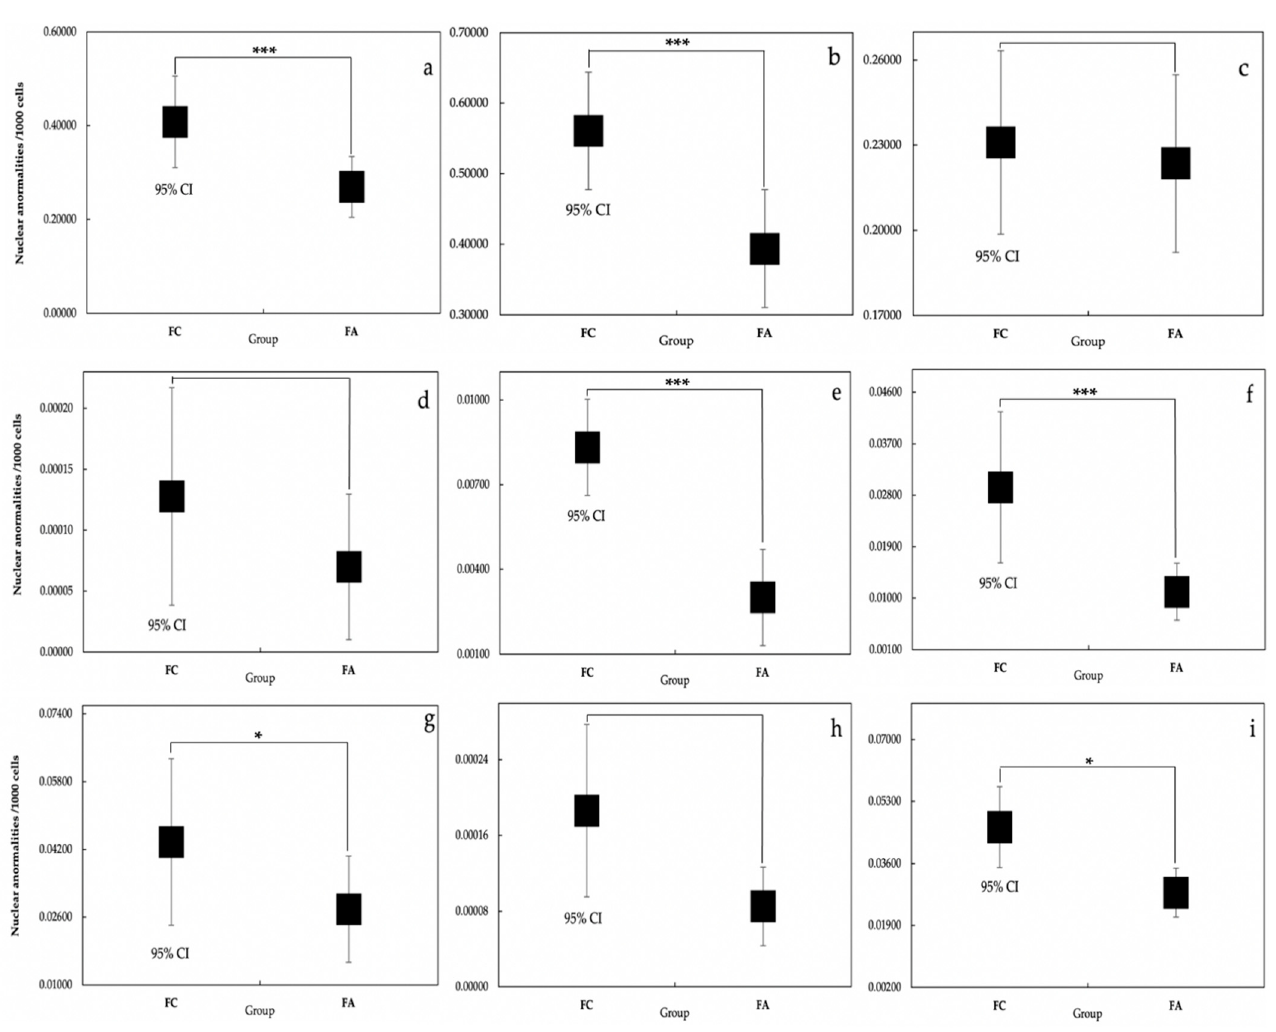
Figure 2. Mean frequency (95% confidence intervals) of nuclear anormalities per 1000 cells in each pool (FC = group of conventional farmers; FA = group of farmers using agroecological practices): ( a ) total number of micronuclei (MNi); ( b ) condensed chromatin (CC); ( c ) karyolysis (KL); ( d ) binucle- ate cell (BN); ( e ) micronuclei (MN); ( f ) karyorrhexis (KR); ( g ) pyknosis (PY); ( h ) basal cells (BC); ( i ) lobed nuclei (BUD). * Significant statistical differences. *** Highly significant statistical differences. Table 5. Total micronuclei (MNi) with respect to sociodemographic variables, confounding factors, and personal protection measures of corn producers from the town of Vicente Guerrero in the municipality of Españita, Tlaxcala,